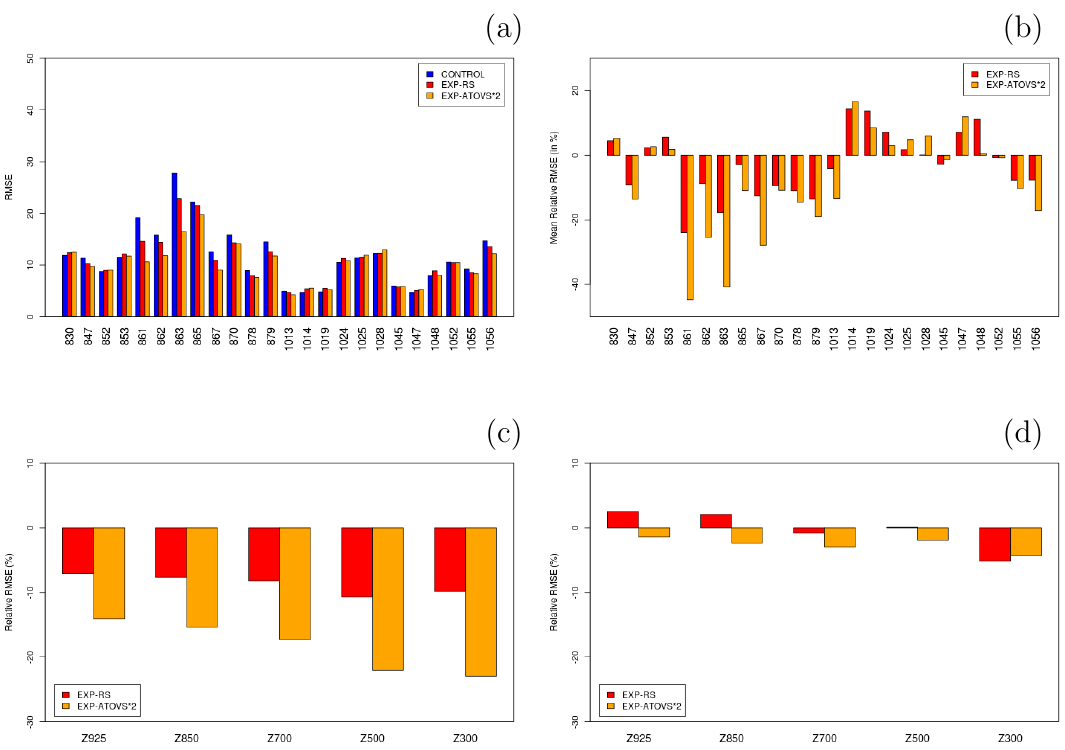
Fig. 5. Top: for each case, RMSE of 500hPa geopotential height forecasts (in metres) for EXP, EXP-RS and EXP-ATOVS*2 experiments (a) , and relative RMSE (in %) of 500hPa geopotential height forecasts for data targeting experiments EXP-RS and EXP-ATOVS*2 (b) . Bottom: relative RMSE (in %) of 925, 850, 700, 500 and 300hPa geopotential height forecasts for data targeting experiments EXP-RS and EXP-ATOVS*2 for 2008 cases (c) and 2009 cases (d)